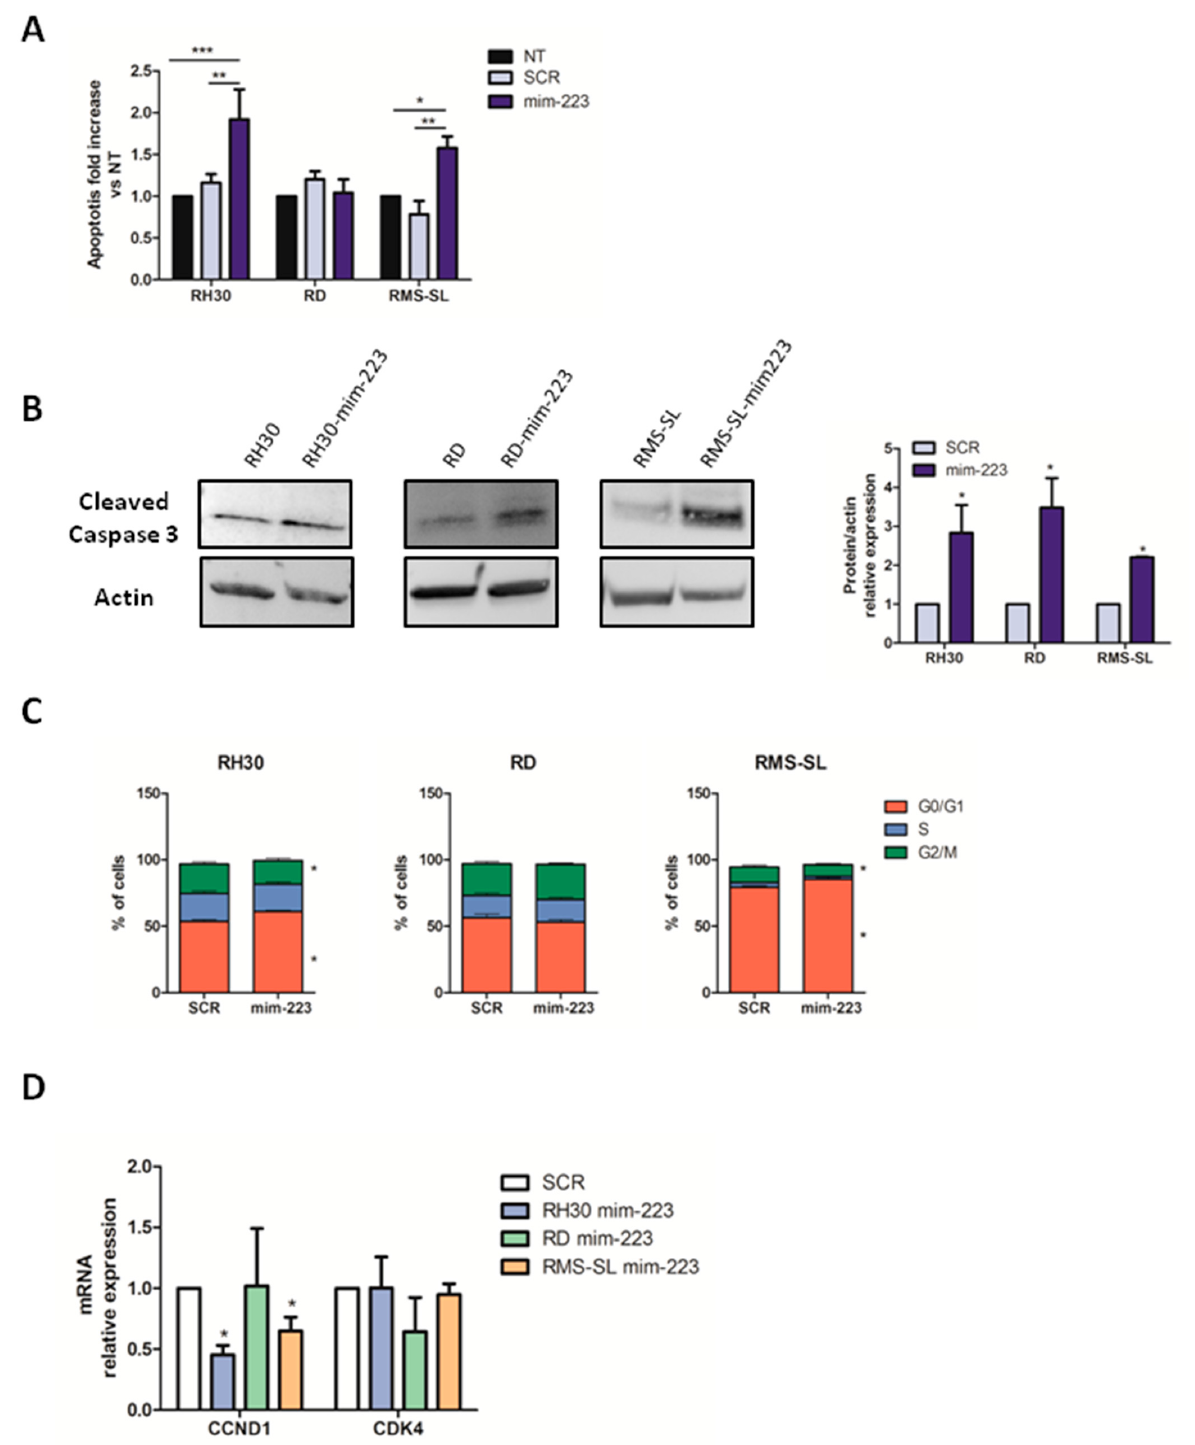
Figure 2. MiR-223 induced apoptosis and cell cycle arrest in adolescent RMS cells. ( A ) Apoptosis was measured by flow cytometry as annexin V + cells compared to SCR and untreated (NT) cells ( n = 5 for each cell lines). ( B ) Representative western blot bands and quantification of Cleaved Caspase 3 in RMS-mim-223 cell lines compared to their SCR controls ( n = 3 for each cell lines). ( C ) Histograms show the percentage of miR-223 over-expressing cells in the different phases of cell cycle compared to SCR cells ( n = 4 for each cell lines) ( D ) mRNA levels of CyclinD1 and CDK4 after over-expression of miR-223 ( n = 5 for each cell lines). All data are expressed as mean ± SEM. * p < 0.05, ** p < 0.01, *** p < 0.001 vs. SCR or NT